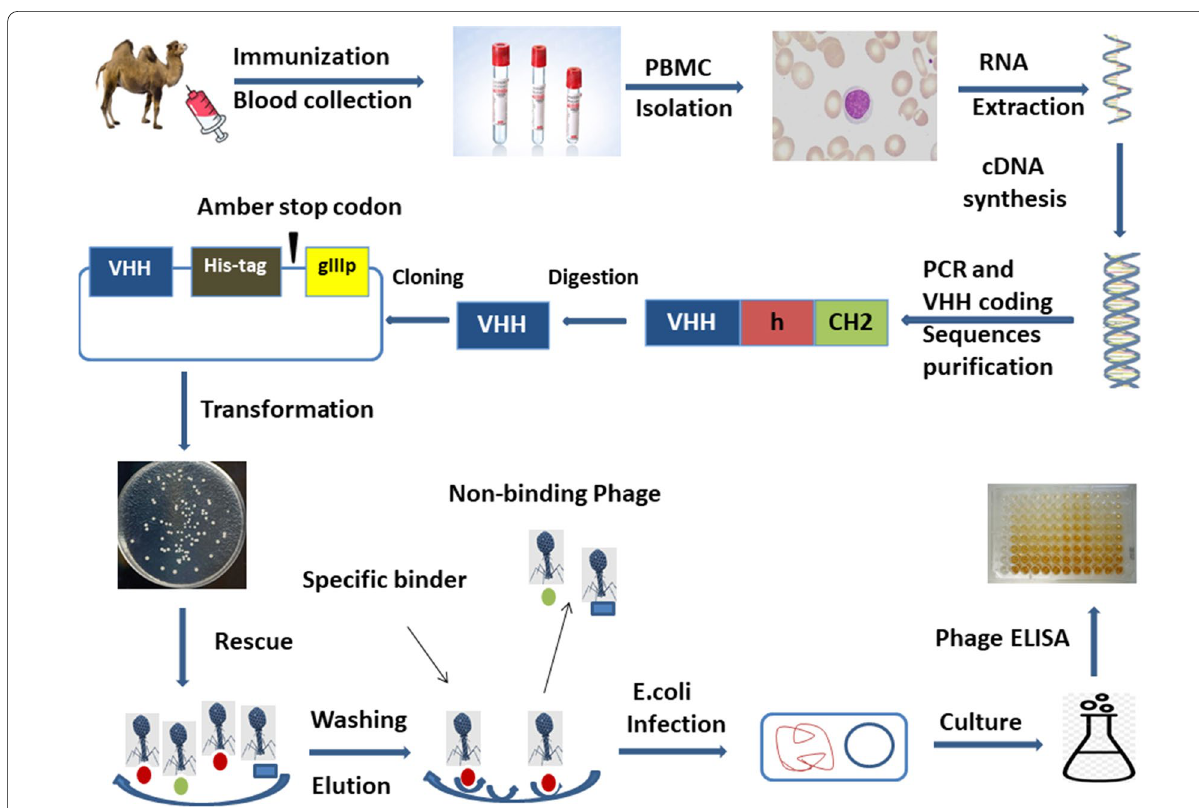
Fig. 1 Schematic diagram of the construction and screening of a single-domain phage display library. The Bactrian camel was immunized with adenoviruses rAd26 and ChAd63, and the blood was collected to isolate peripheral blood mononuclear cells (PBMCs). Total RNA was extracted from PBMCs and reverse transcribed into cDNA. The VHH gene fragments were amplified using PCR. In the first round of PCR, a fragment of approximately 600 bp from the leader sequence to the CH2 domain was amplified from the cDNA. The full-length VHH gene from FR1 to FR4 was amplified using P 3 and P 4 primers in the second round of PCR. The PCR-amplified product was digested using the restriction enzymes Nco I and Not I . The VHH gene was ligated into the pMECS plasmid and transformed into E. coli TG1. After rescue by the M13k07 helper phage, the VHH gene was displayed on the phage surface, and the specific phages were enriched and selected using phage